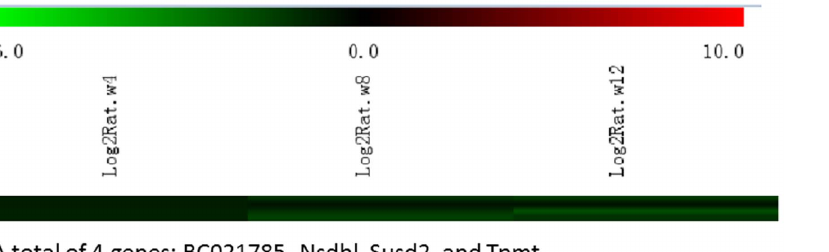
Figure 4. The Heat Map and the list of genes which were down-regulated at all three time points (4, 8, 12 weeks of age). There were only 4 genes in the list.